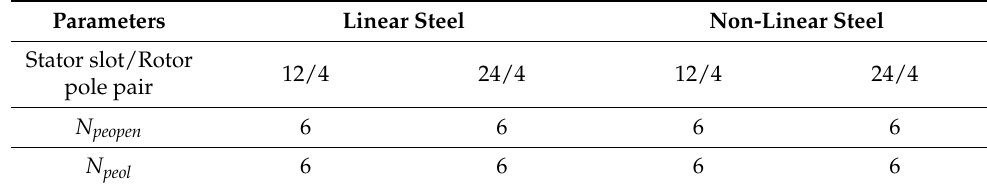
Table 5. FEA Predicted DC Winding Induced Voltage Cycles per Electrical